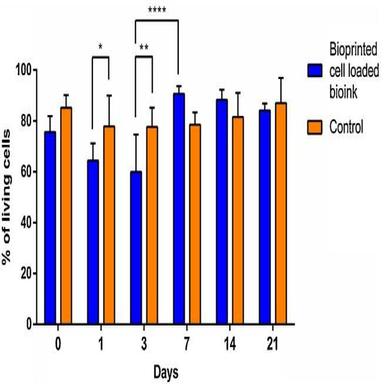
Viability of HFF-1 cells loaded into 3D printed constructs during static culture for 21 days. Deposited cell loaded ZS-EI-ELR bioink was used as control. (ns P > 0.05; \P < 0.05; \\P < 0.01; \\\P < 0.001; \\\\P < 0.0001).